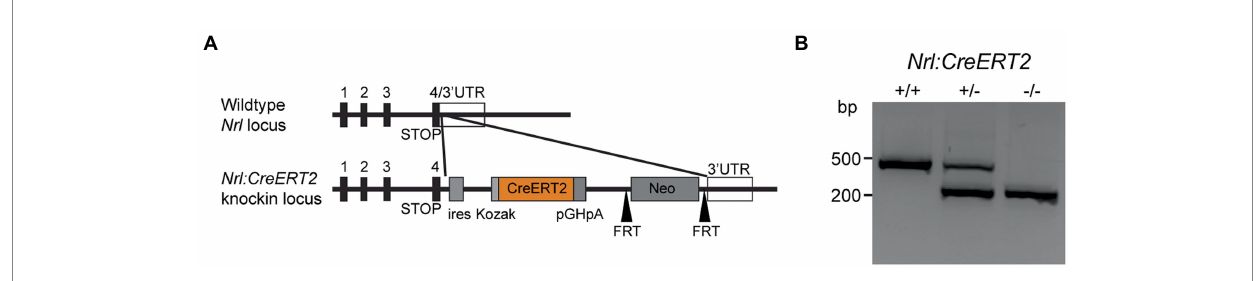
FIGURE 1 Tamoxifen-inducible Nrl:CreERT2 mouse. (A) Gene diagram for CreERT2 insertion within the Nrl locus. (B) Agarose gel showing bands produced by genotyping PCRs on isolated genomic DNA from Nrl:CreERT2 +/+ , Nrl:CreERT2 + /− , and Nrl:CreERT2 −/−